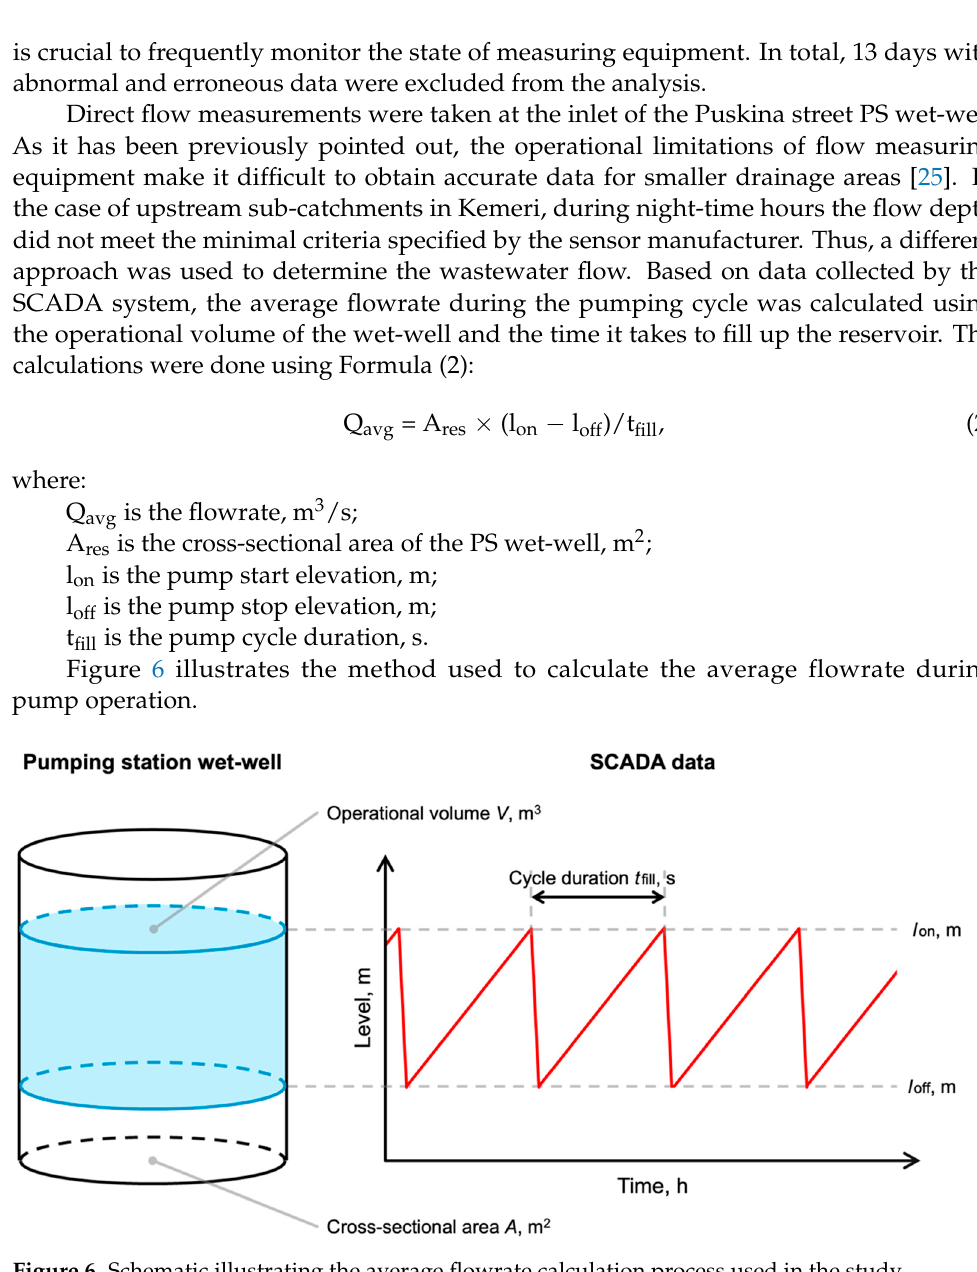
Figure 6. Schematic illustrating the average flowrate calculation process used in the study.